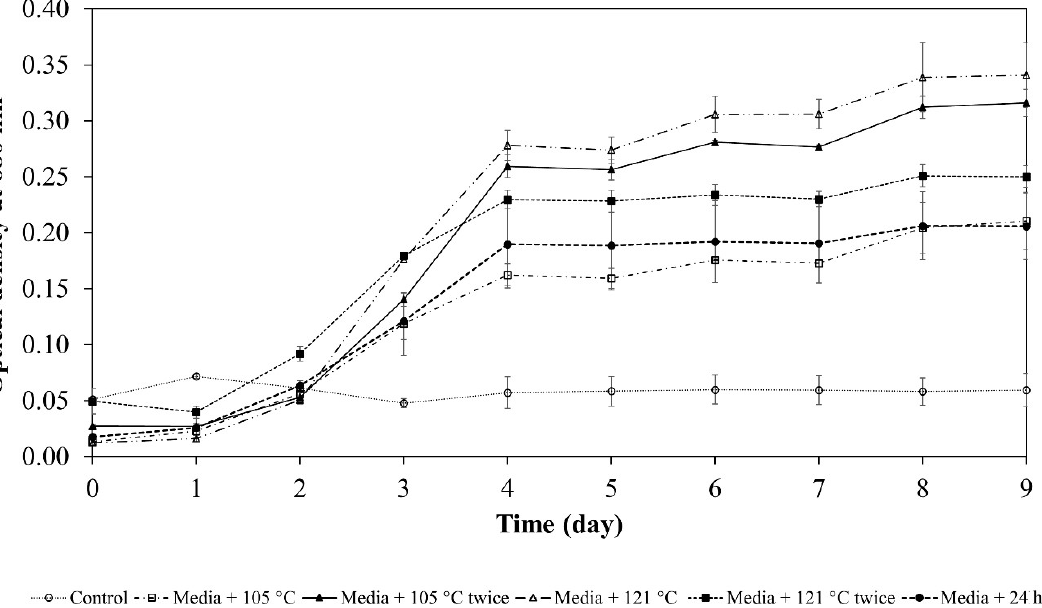
Figure 2. Optical density at 680 nm of Nannochloropsis oceanica . Error bars represent the standard deviation between three replicates ( n = 3).